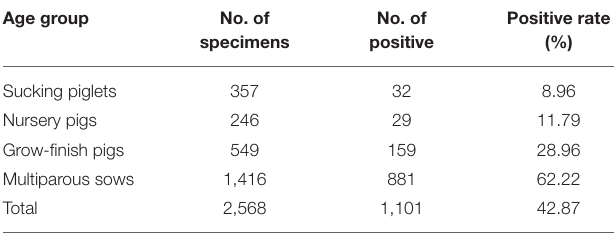
TABLE 2 | Seroprevalence of PCV3 in different age groups in China by